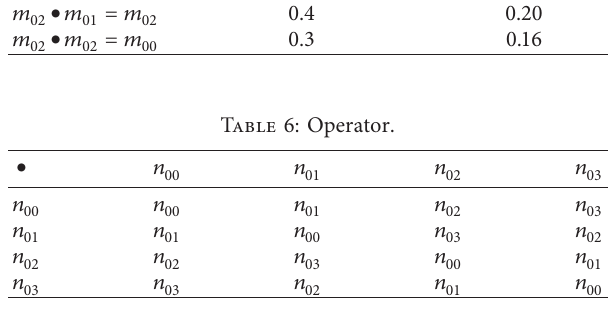
Table 7: Product P